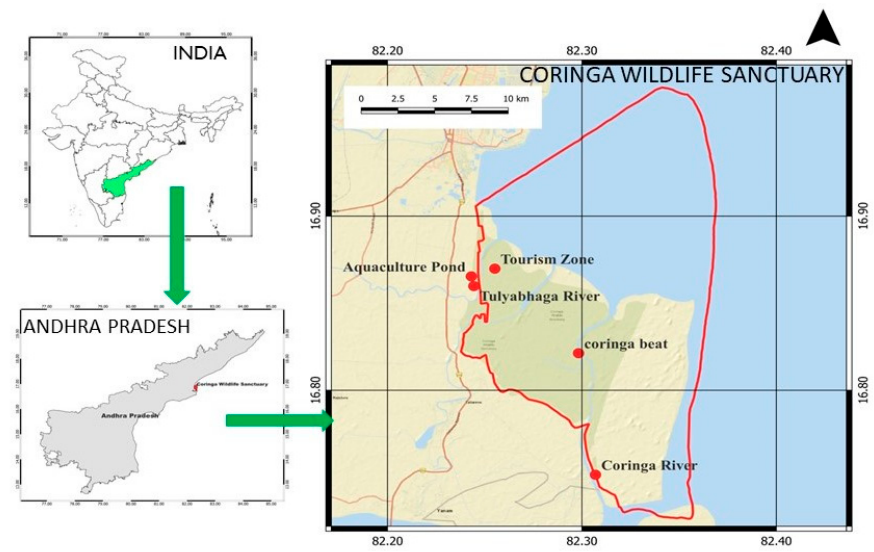
Figure 1. Map showing the five different study sites in the Coringa Wildlife Sanctuary, Andhra Pradesh, India. [Site 1: Tourism zone, Site 2: Coringa river, Site 3: Tulyabhaga river, Site 4: Coringa beat, Site 5: Aquaculture pond].